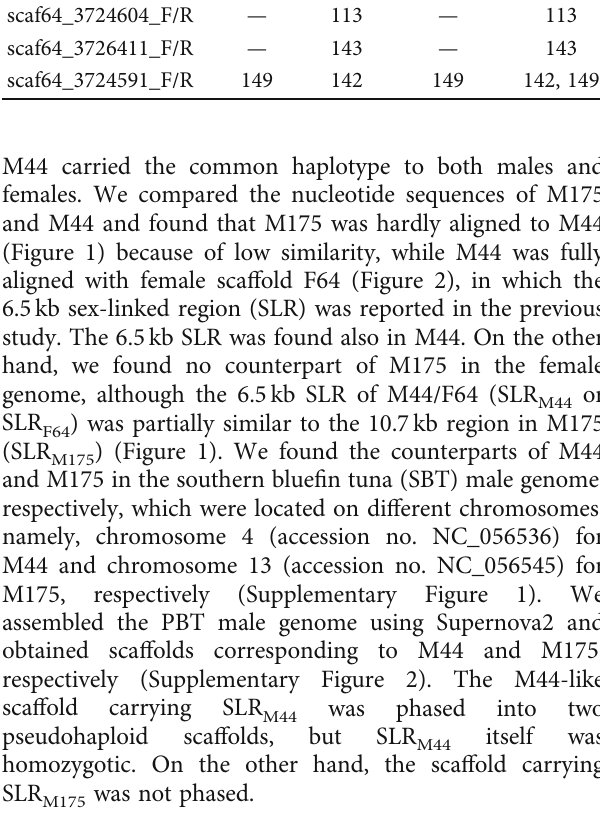
Table 2: Ampli fi ed sizes of sex identi fi cation PCR primer sets. Primer